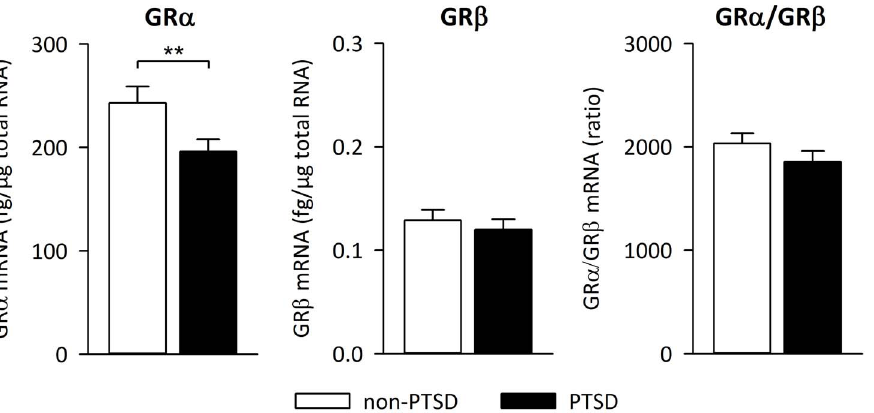
Figure 1. Glucocorticoid receptor isoform expression. Expression levels of glucocorticoid receptor (GR) a and b isoforms as well as GR a /GR b ratio in the peripheral blood of non-PTSD subjects ( n =35) and PTSD patients ( n =42) measured by real-time quantitative PCR. Means and SEM are shown. ** p =0.01. doi:10.1371/journal.pone.0086333.g001 PLOS ONE |